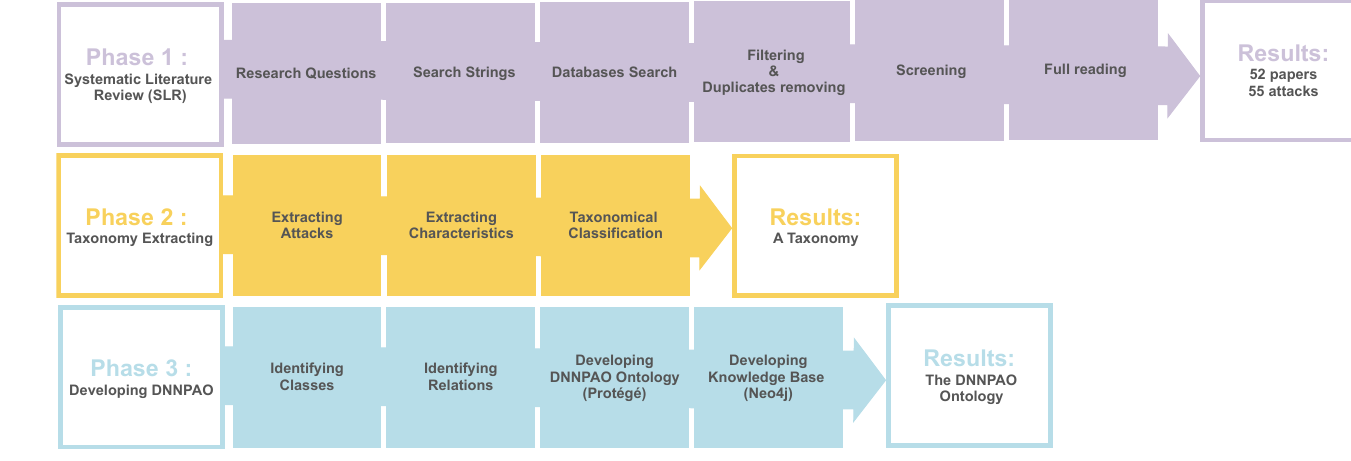
Figure 3. Overall research process in this